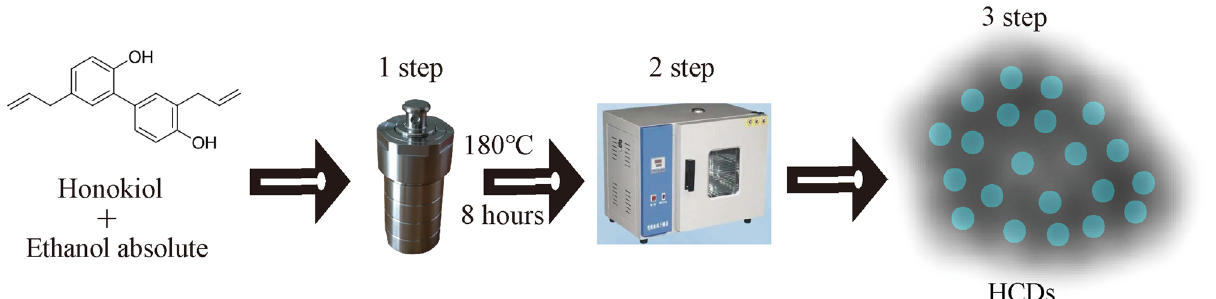
Fig. 1 Graphical description for the preparation of HCDs from Honokiol using a hydrothermal